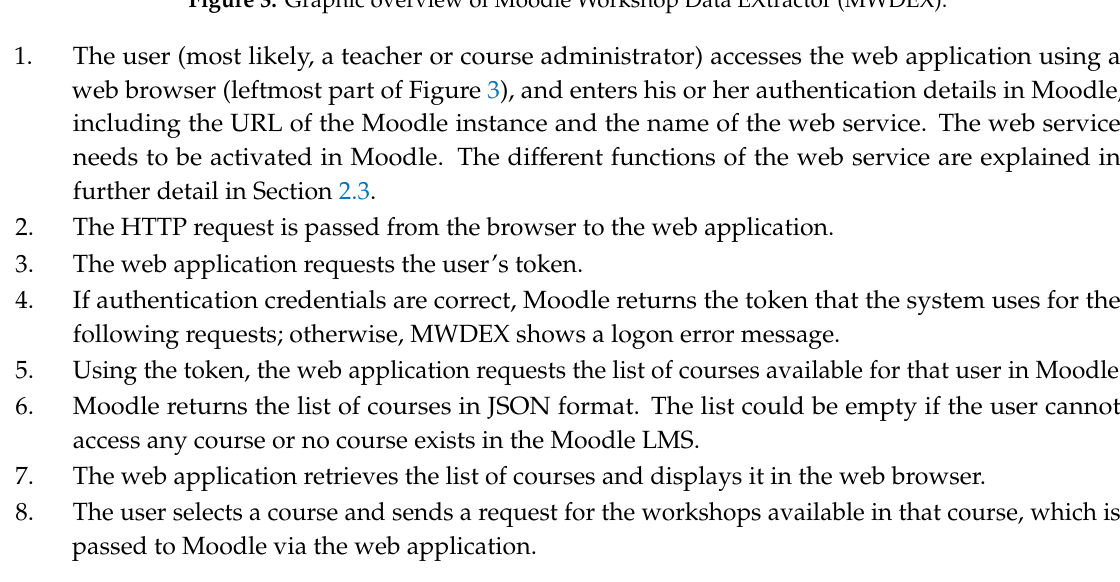
Figure 3. Graphic overview of Moodle Workshop Data EXtractor (MWDEX).